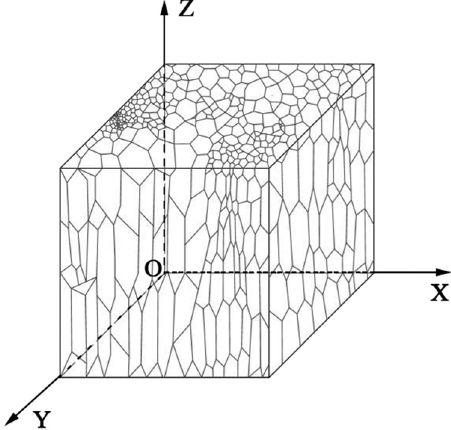
Figure 11: Schematic of growth direction of columnar crystals in cladding